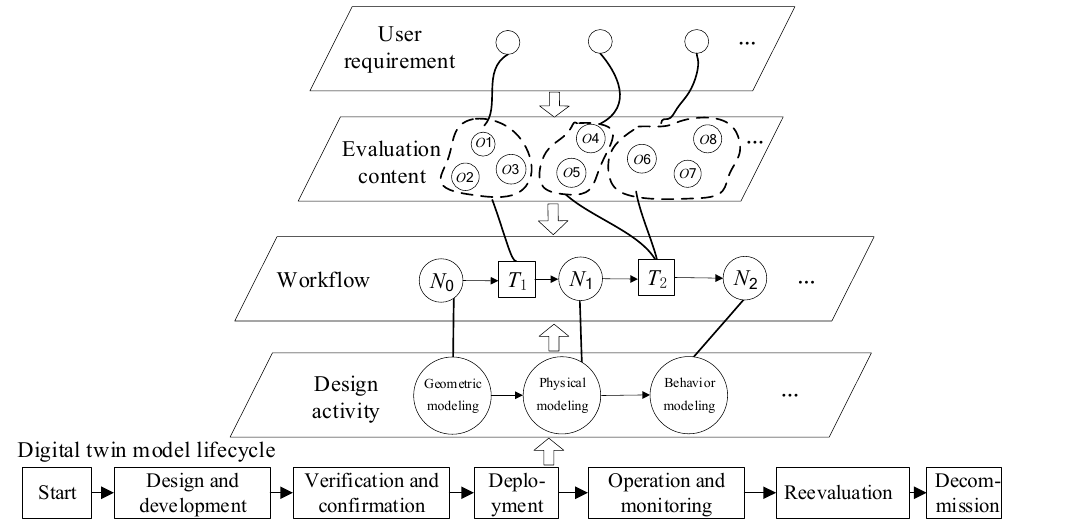
Figure 3. Mapping relationships between design activity, workflow, and digital twin model evalu- ation content.